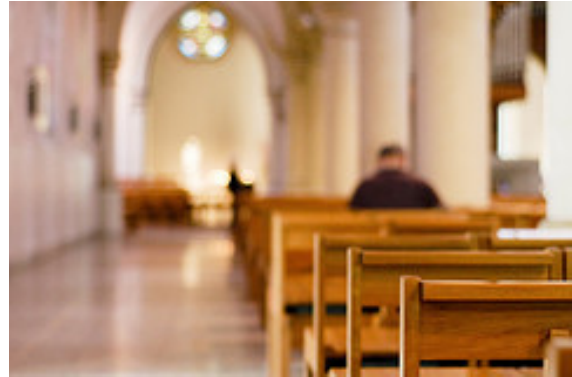
Figure 12: ‘Straightened Perspective’ by Yinyang